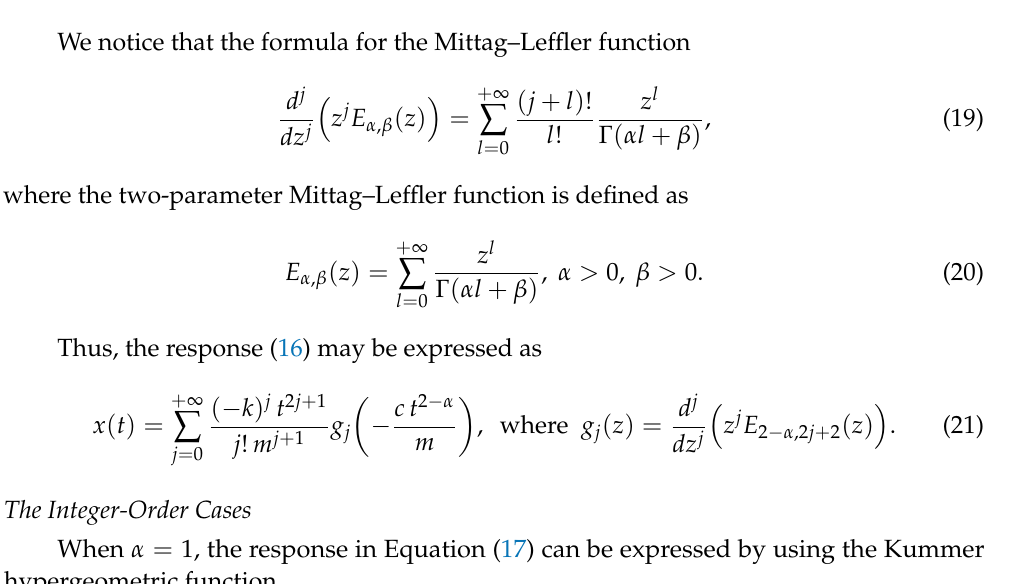
Figure 3. Curves of x ( t ) for m = k = 1, c = 3 and for α = 0 (solid line), 0.25 (dotted line), 0.5 (dashed line), 0.75 (dotted-dashed line), and 1 (dotted-dotted-dashed